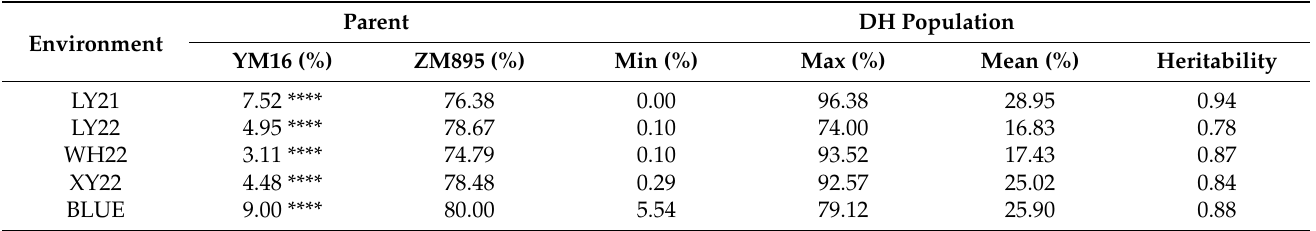
Table 1. GI of the YM16/ZM895 double haploid population and its parents in multiple environments.